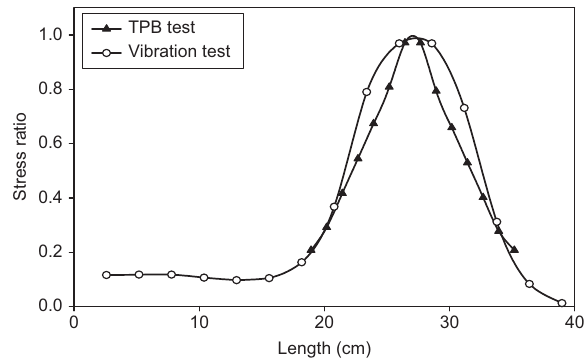
Figure 4 Comparison of the predicted Von Misses centerline stress profi le from TPB specimens and vibration test specimens.